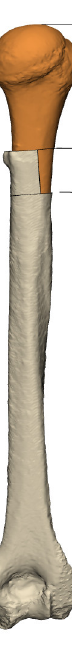
Figure 7. Planned APC dimensions to compensate for humeral bone loss (images from Reflect COM- PLEX TM (Akunah, Brisbane, Australia)). COMPLEX TM (Akunah, Brisbane,